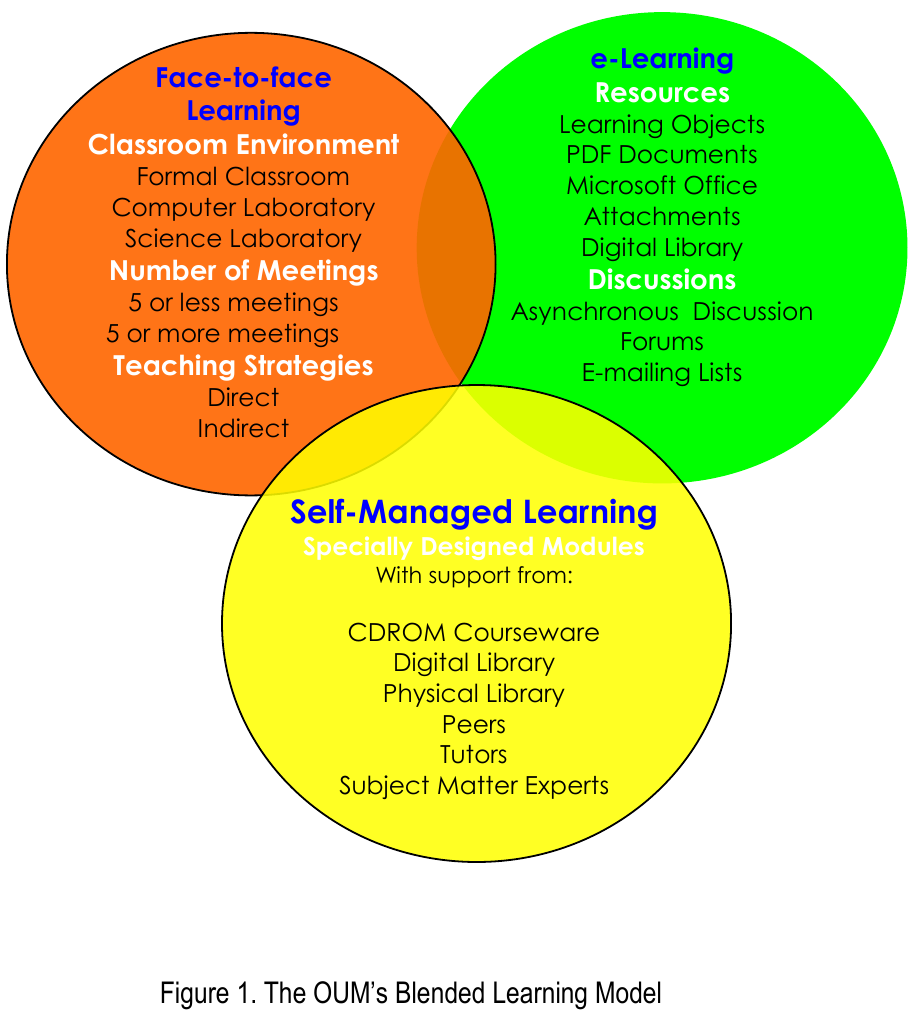
Figure 1. The OUM’s Blended Learning Model